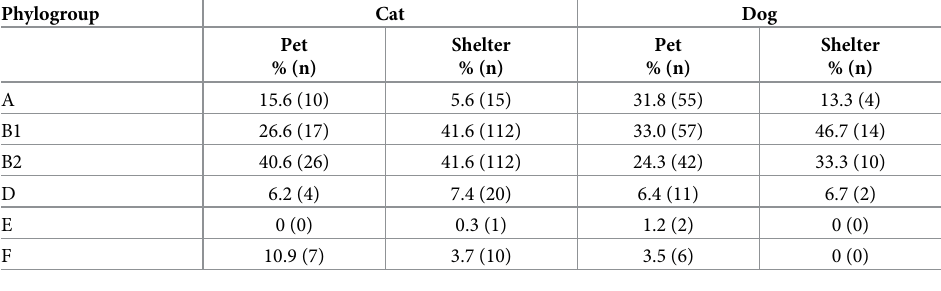
Table 1. The relative abundance of E . coli phylogroups among 203 E . coli isolates from 221 dogs and 334 isolates from 427 cats. Phylogroup Cat